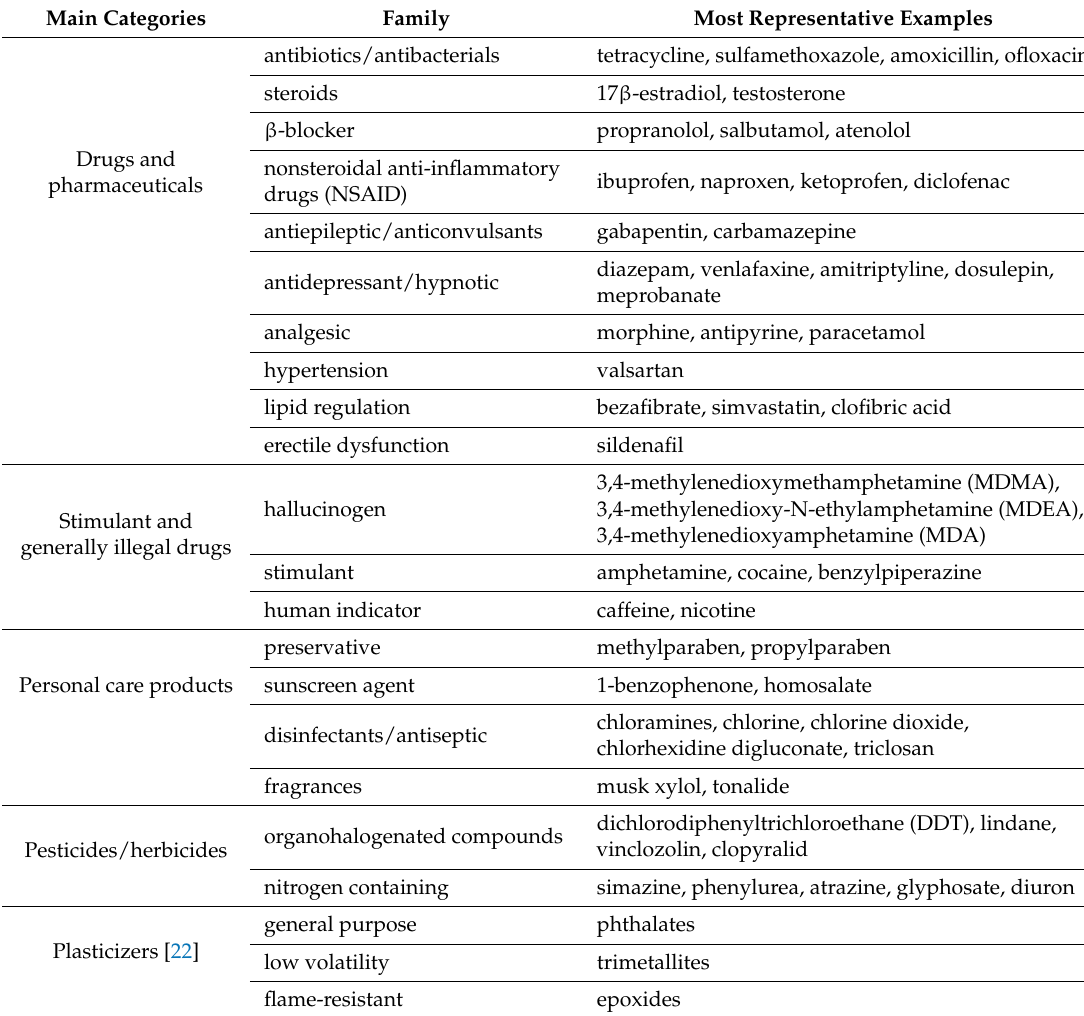
Table 1. Emerging contaminants (ECs) usually found in wastewater (adapted from